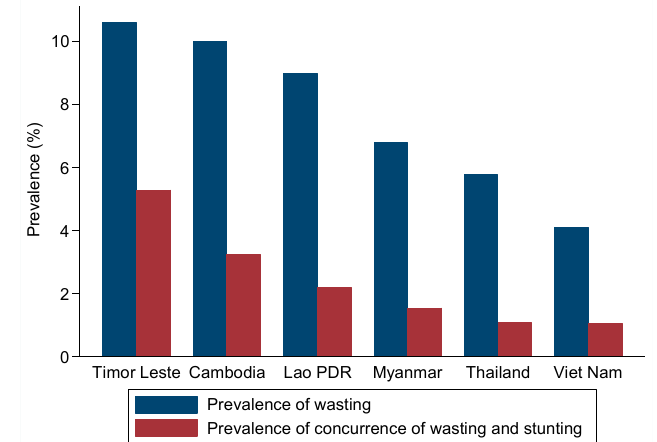
Figure 2. Prevalence of wasting and concurrence of wasting and stunting by country.